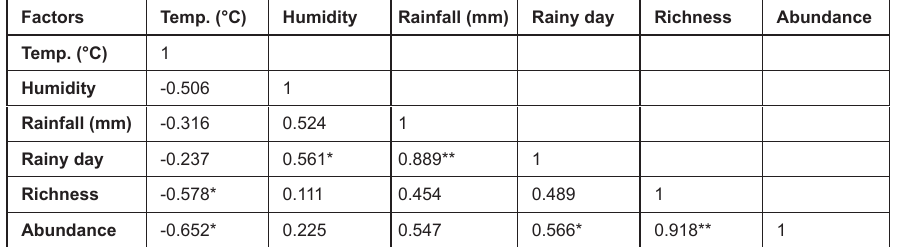
Table 4. Correlation between weather parameter and butterfly population in DAE Campus,